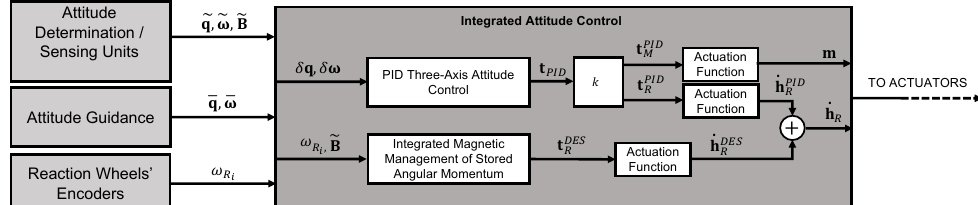
Figure 2. Attitude control system architecture